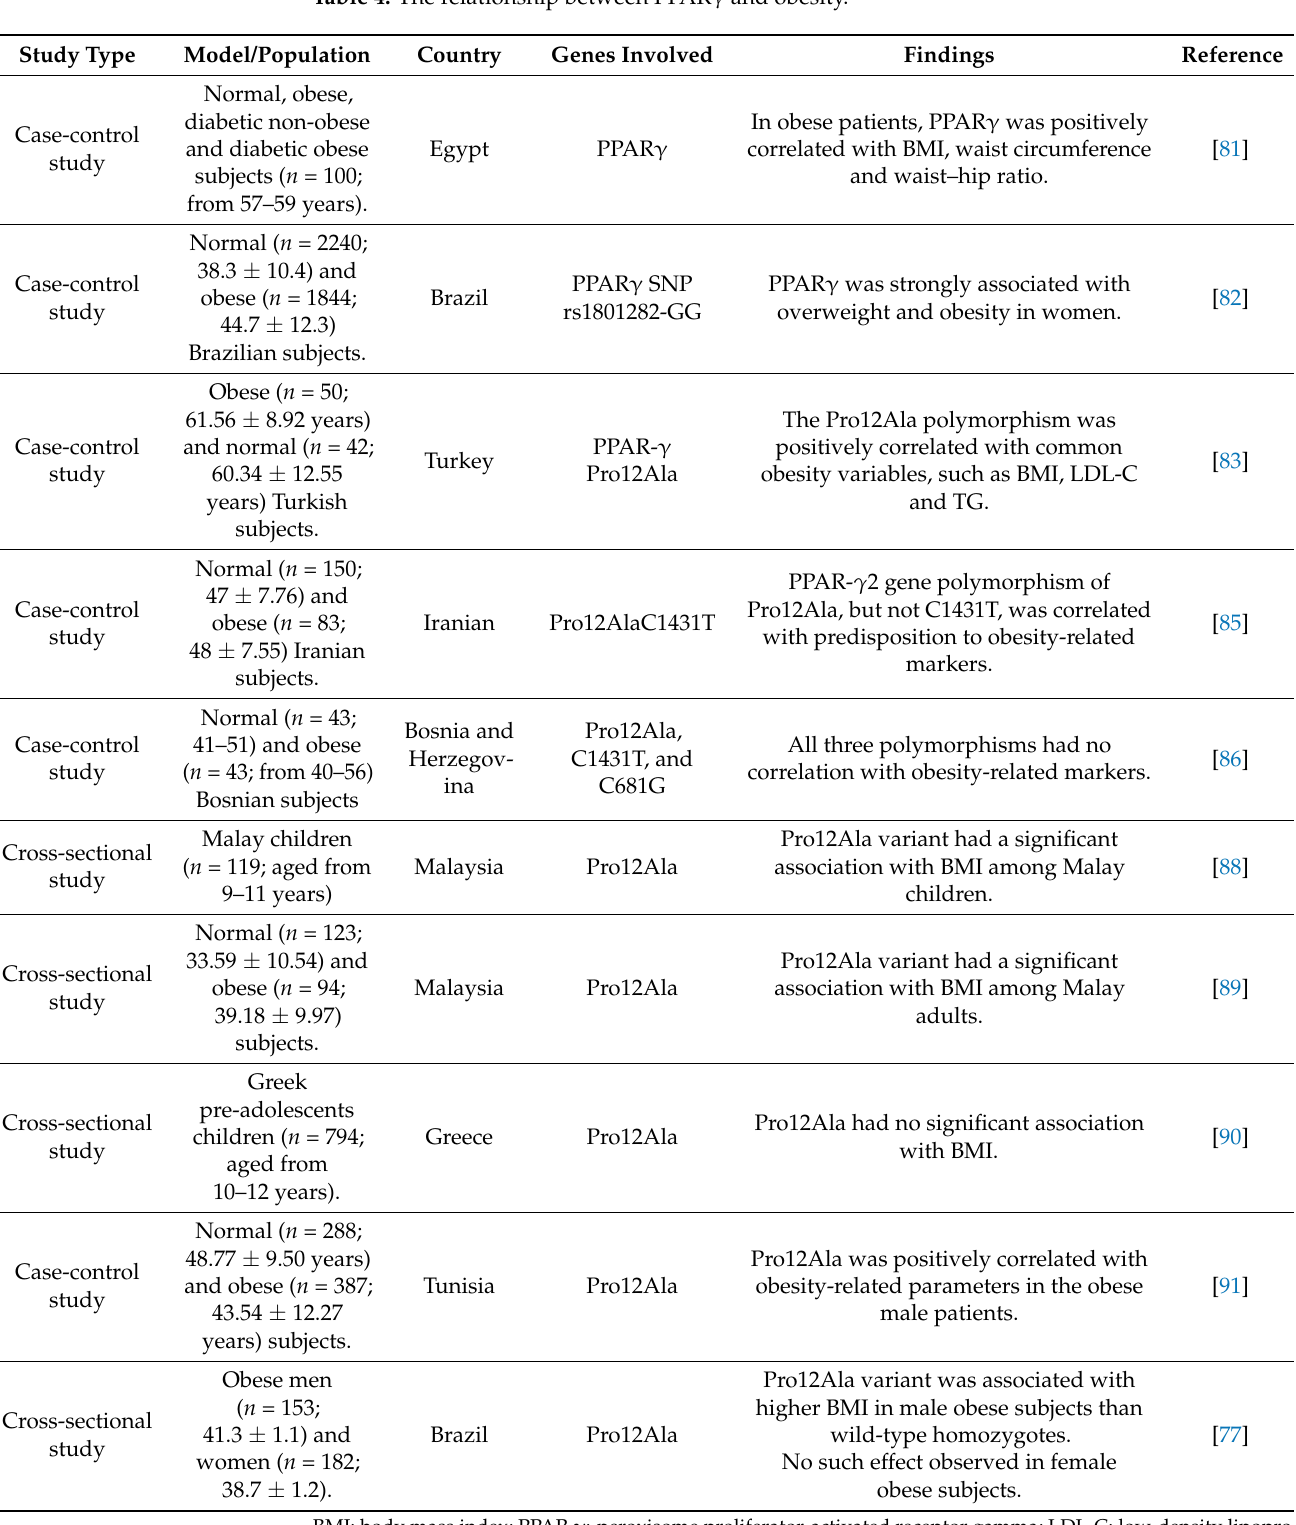
Table 4. The relationship between PPAR γ and